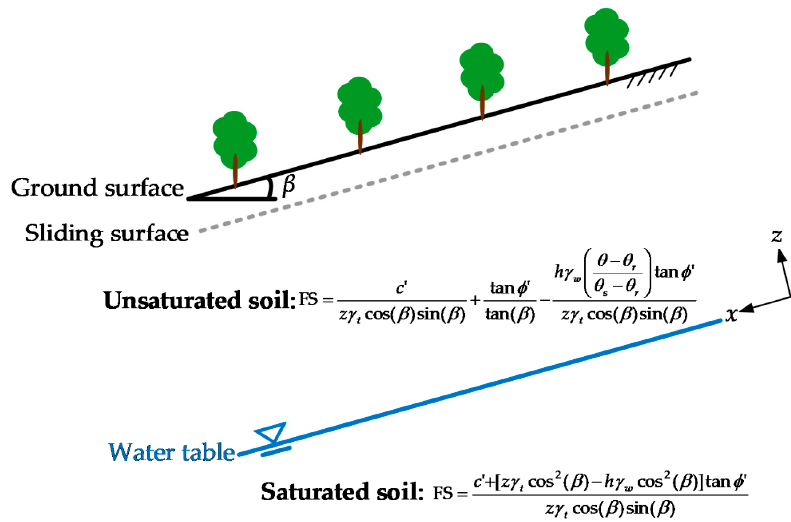
Figure 2. Landslide stability for a variably saturated infinite slope. Water 2022 , 14 , x FOR PEER REVIEW